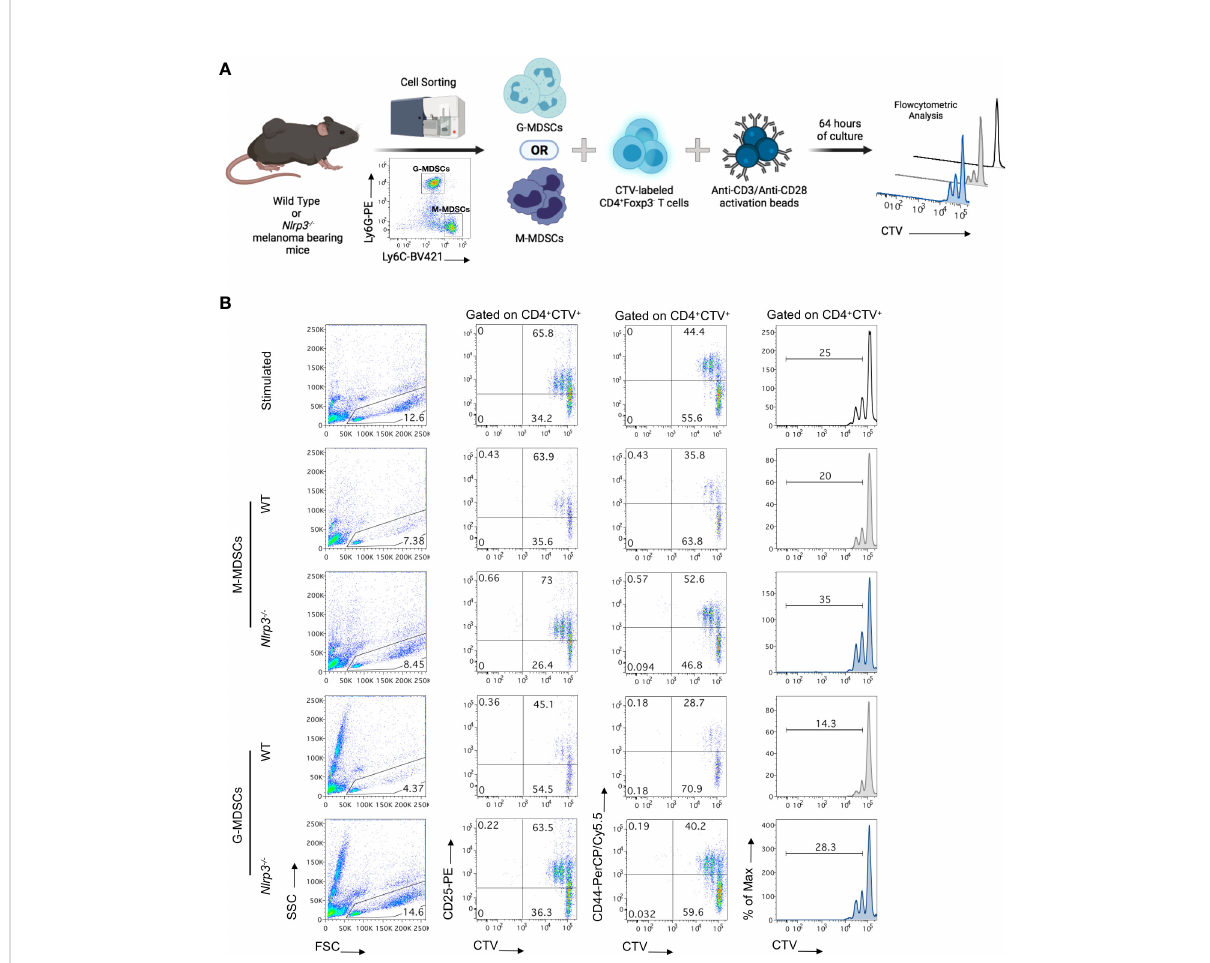
FIGURE 7 MDSC subsets from Nlrp3 -/- mice exhibit an impaired suppressive function. (A) Schematic representation of the in vitro experimental setup for the evaluation of the suppressive ability of MDSC subsets. M-MDSCs and G-MDSCs were sorted from the spleen of WT ( n = 2) and Nlrp3 -/- ( n = 2) melanoma-bearing mice and were co-cultured, at different ratios, with CellTrace Violet (CTV)-labeled T effectors (CD4 + Foxp3 – ) cells, isolated from the lymph nodes (LNs) of Foxp3 GFP naïve mice and activated by anti-CD3/anti-CD28 monoclonal antibodies. Suppressive activity of MDSC subsets was estimated 64 h later by fl ow cytometry. (B) Representative FACS plots showing the percentages of lymphocytes according to FSC and SSC, frequencies of CD4 + CTV + CD25 + and CD4 + CTV + CD44 + populations, and histograms of CTV MFI dilution of different culture conditions (T:M-MDSCs 1:1; T:G-MDSCs 3:1). Histogram plots were gated on CD4 + CTV + cells and thus represent Teff cell proliferation. Numbers in histograms represent percentages of proliferated cells. Representative data from two independent mouse samples ( n ) are shown. Illustration created with